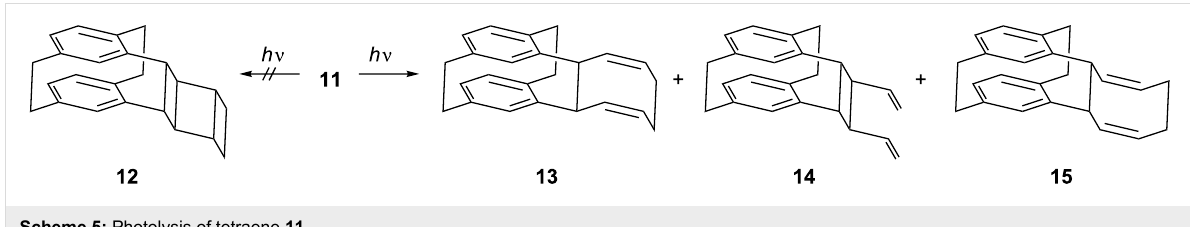
Scheme 5: Photolysis of tetraene 11 .